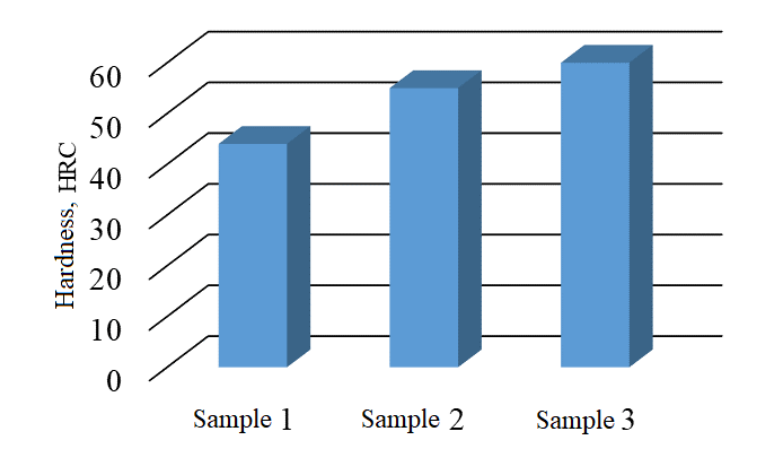
Fig.8 . Chart of hardness of